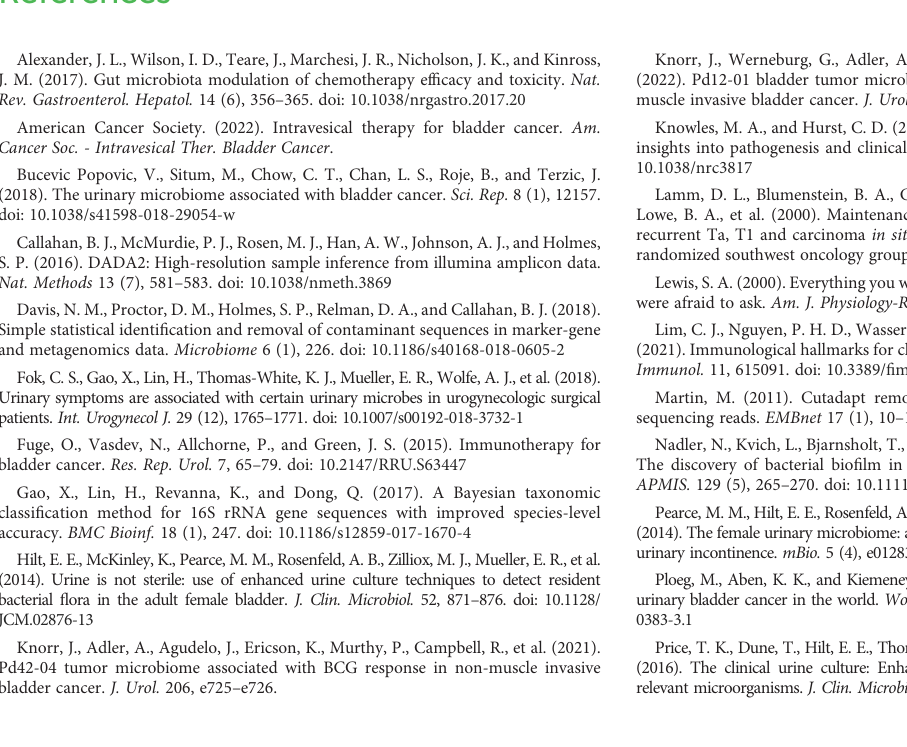
SUPPLEMENTARY FIGURE 2 Box plot demonstrating Simpson Diversity Index measures for non- recurrence and recurrence patients within the cohort across beginning, middle and end timepoints. The y-axis displays the value of the Simpson Diversity Index. The x-axis indicates timepoint. SUPPLEMENTARY FIGURE 3 Box plot demonstrating richness measures for non-recurrence and recurrence patients within the cohort across beginning, middle and end timepoints. The y-axis displays the richness values. The x-axis indicates timepoint. SUPPLEMENTARY FIGURE 4 Box plot demonstrating evenness measures for non-recurrence and recurrence patients within the cohort across beginning, middle and end timepoints. The y-axis displays evenness value. The x-axis indicates timepoint. SUPPLEMENTARY TABLE 1 Detailedsample processing,preparation, bioinformatic,andanalytic methods for 16S rRNA gene